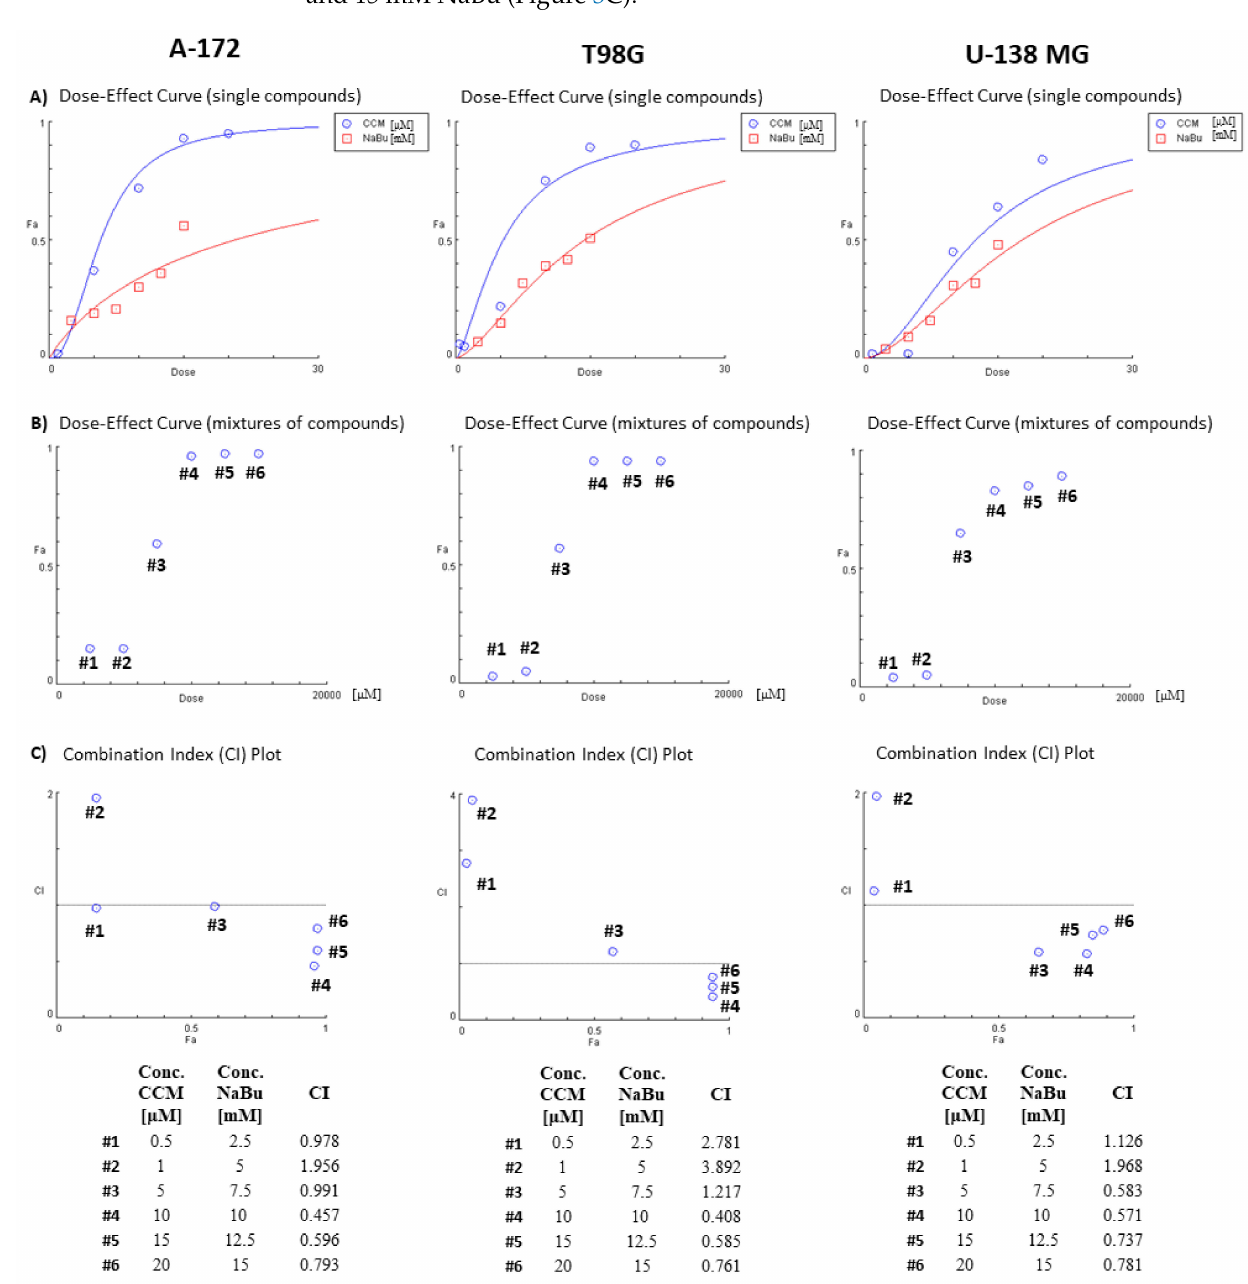
Figure 3. Results of analysis of combinatorial effects of CCM and NaBu and their combination treatment on GBM cell viability based on MTT assay. A-172, T98G, and U-138 MG cells were treated with increasing concentrations of individual compounds and their combinations for 48 h. Control cells were treated with vehicle. Mean values from three independent experiments were used in calculations using CompuSyn software. Dose-effect curves for individual compounds (panel A ) or combination treatment (panel B ) were generated. (Panel C ) presents evaluation of the combination index (CI). Synergistic action of chemicals in combinations was identified when CI < 1 (the area below the grey line in Panel C graphs). Synergistic interactions in terms of the reduction of cell viability were obtained for concentrations higher than 1 µ M CCM and 5 mM NaBu. Fa—Fraction affected: viability reduction from lack of effect (0) to maximal effect (1; viability =